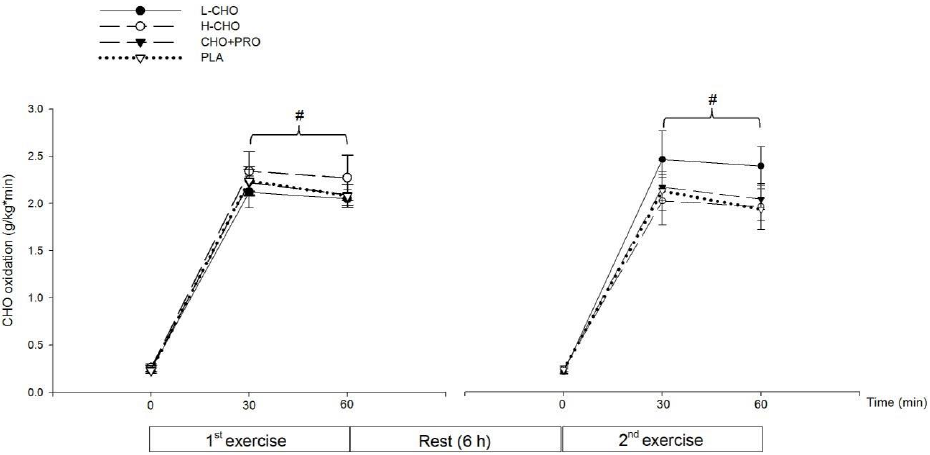
Figure 3. CHO oxidation rate in the first and second exercise sessions in study II ( # : vs. 0 min in the same exercise bout, p < 0.05).